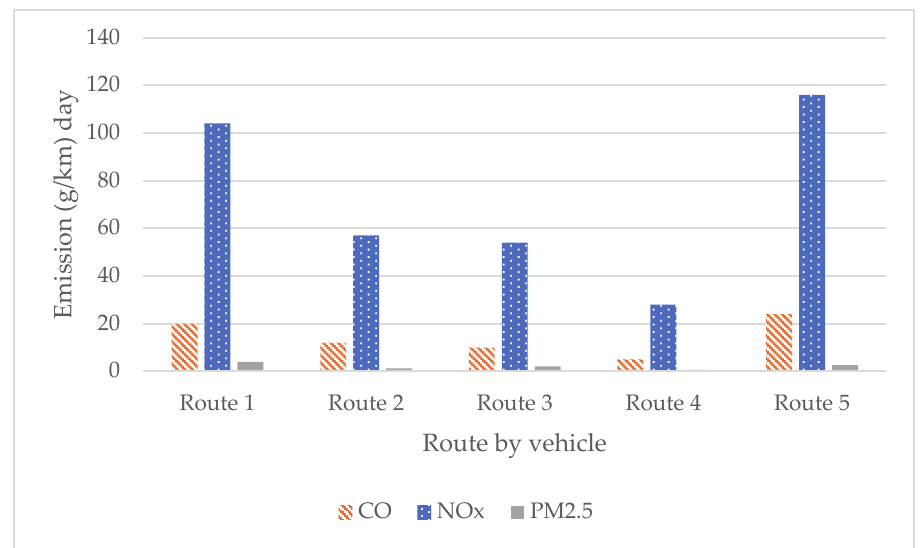
Figure 3. Emission of CO, NOx, and PM 2.5 of the different routes.